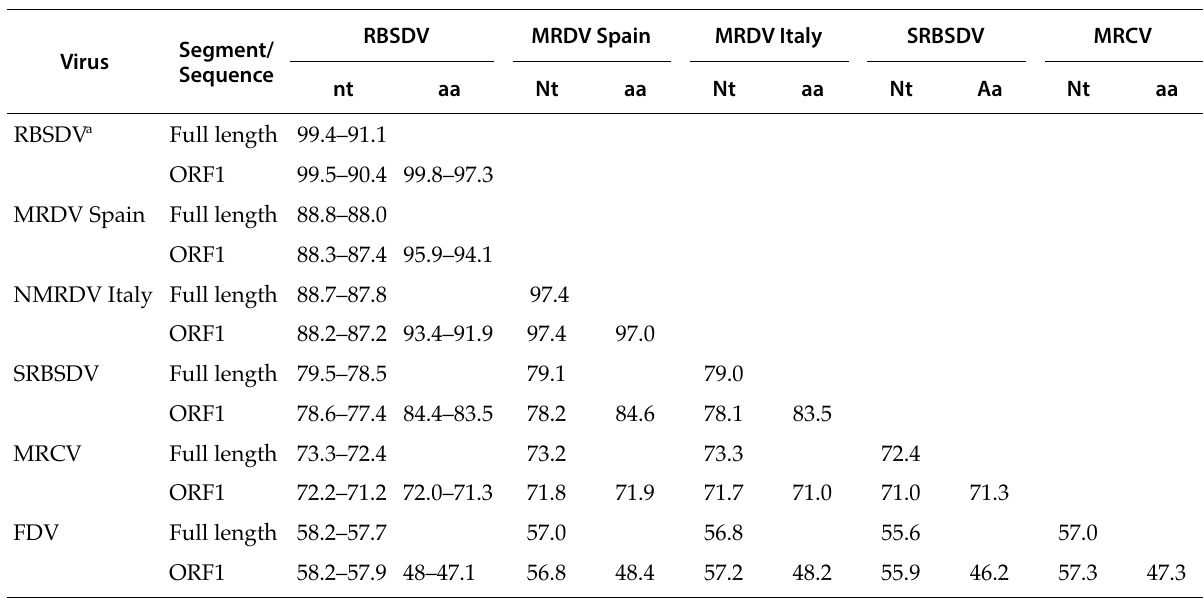
Table 5. Sequence identity (%) among species of the Fijivirus genus that infect maize at the S10 full length and ORFs at nucleotide and amino acids